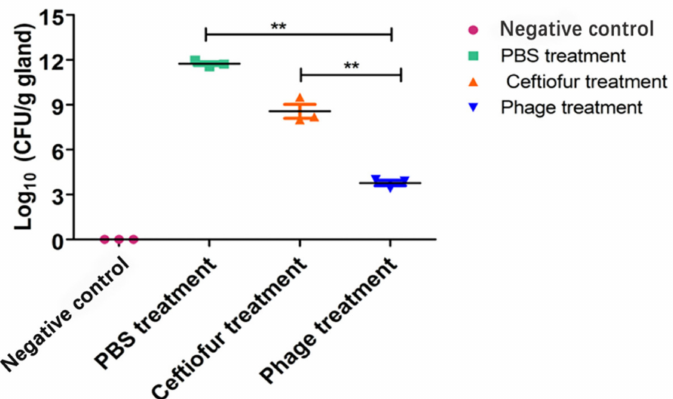
Figure 8. S. aureus CFUs in the mammary glands after phage treatment. Each point on the graph corresponds to the log 10 CFU/g value of an individual gland. The bar represents the median value for each group. **, p <